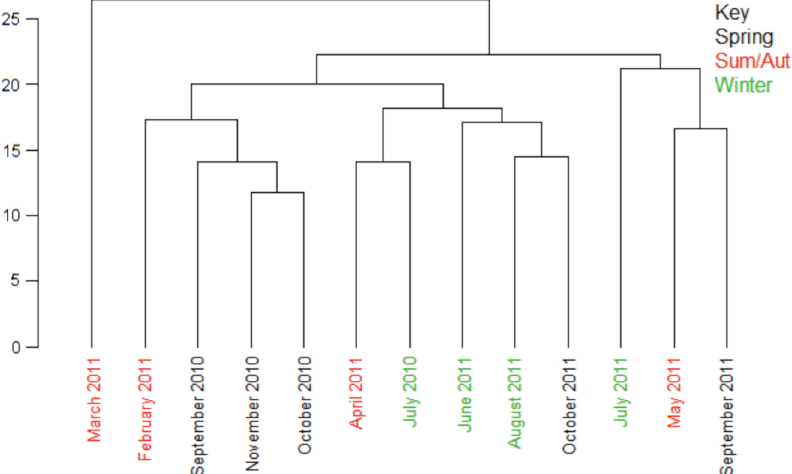
Figure 2: Dendrogram plot of the hierarchical clustering, with Euclidean distance between samples. Spring samples are in black, summer/autumn samples in red and winter samples in